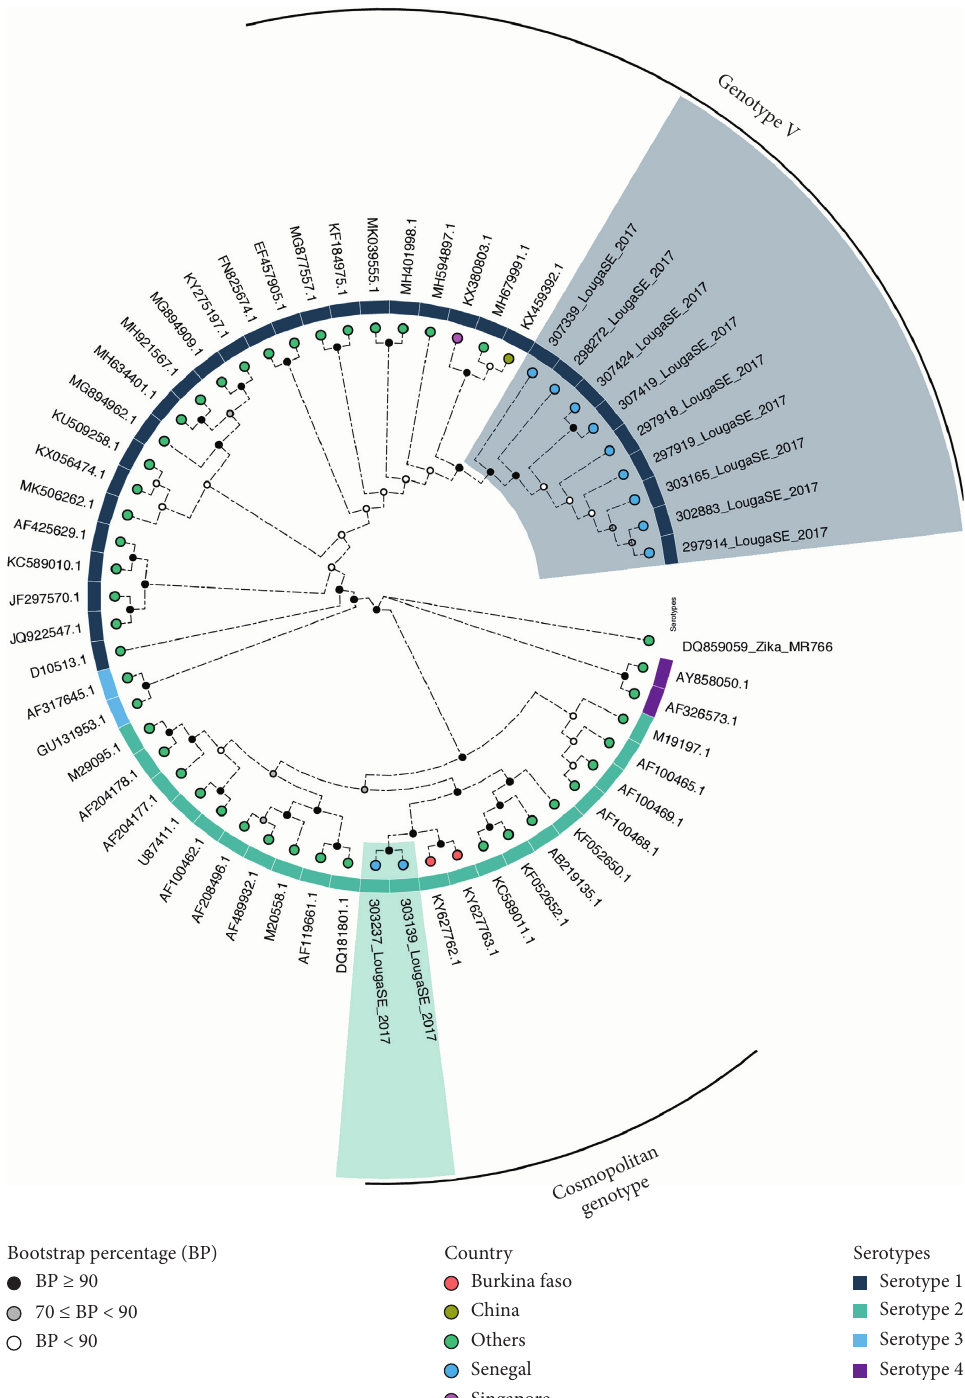
Figure 4: Phylogenetic analysis of complete E gene of the Louga City outbreak isolates. The analysis was run using an alignment rep- resenting the described dengue virus serotype 1 and 2 genotypes, in addition to the Louga strains highlighted, respectively, in light blue (serotype 1) and light green (serotype 2). The maximum likelihood phylogeny applying the TIM2+ F + R 8 model was generated using IQ- tree, and tree support was calculated after 1000 bootstrap